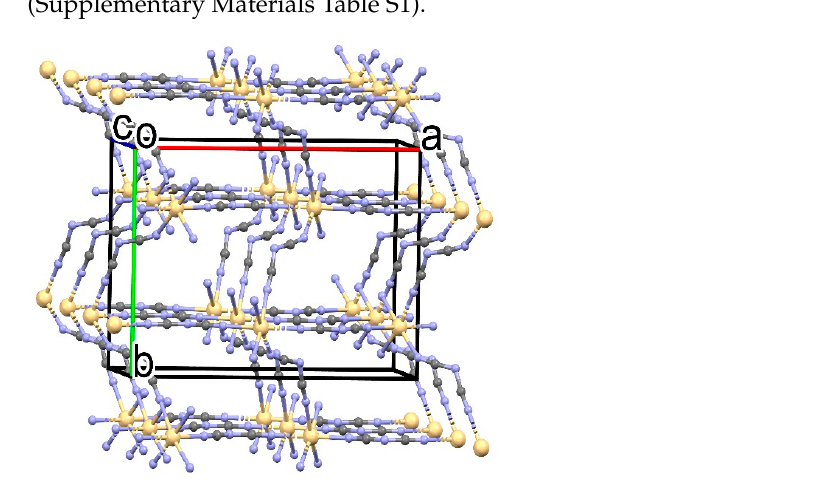
Figure 5. The 3D Cd-dca network in 5 . The C and H atoms of Me 4 en and one orientation of disordered dca2 group were omitted for clarity. (Color code: yellow, Cd; blue, N; black, C.)